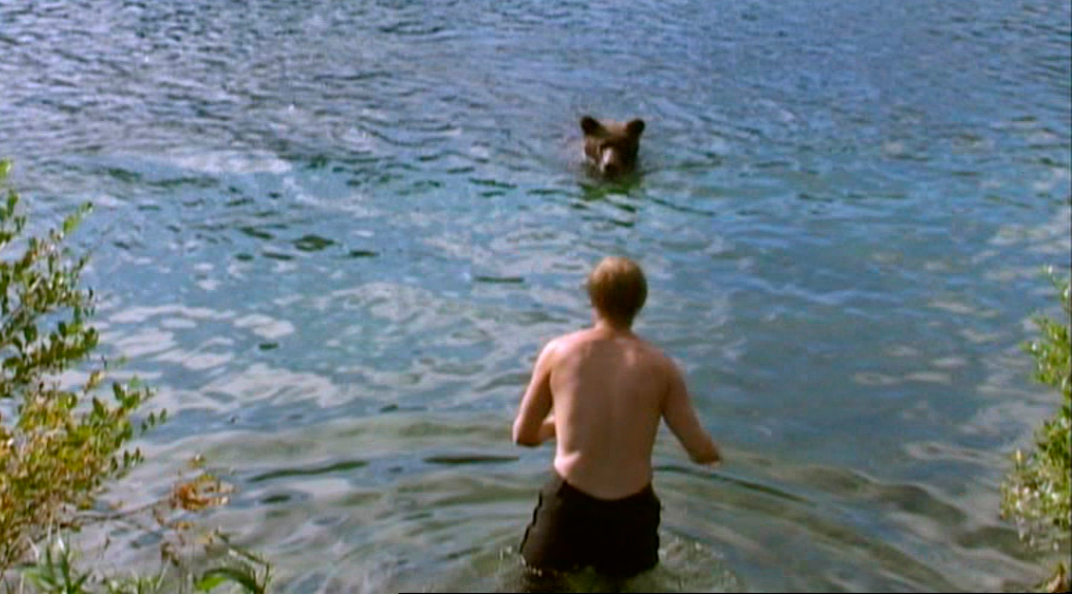
Figure 1. Treadwell filming himself with a bear.